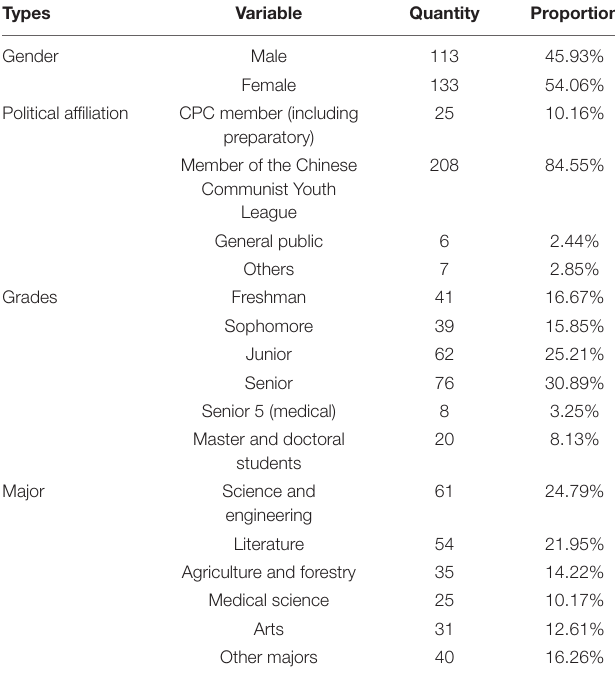
TABLE 1 | Basic information of survey